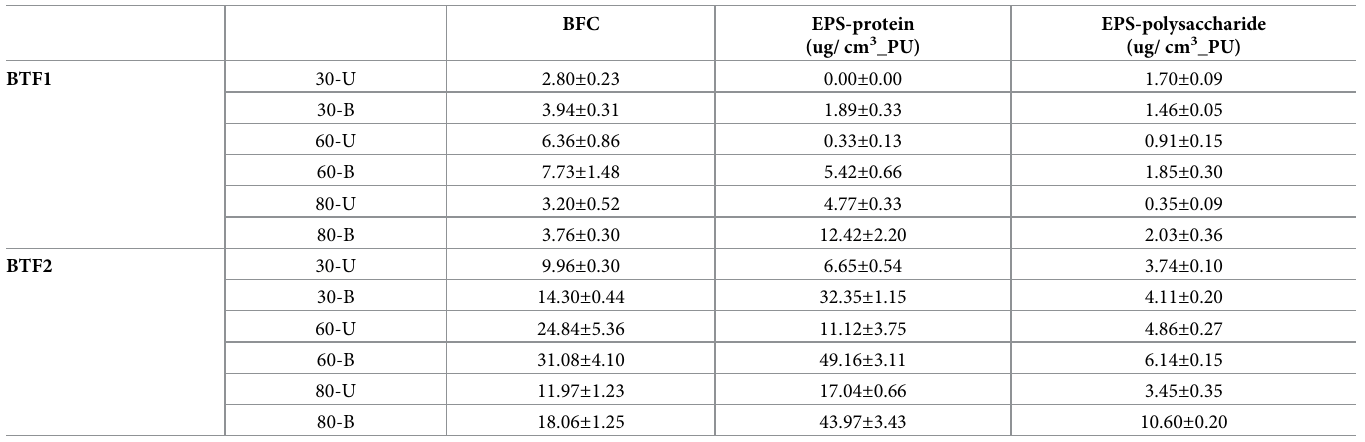
Table 1. Biofilm formation capacity and EPS production during the operation